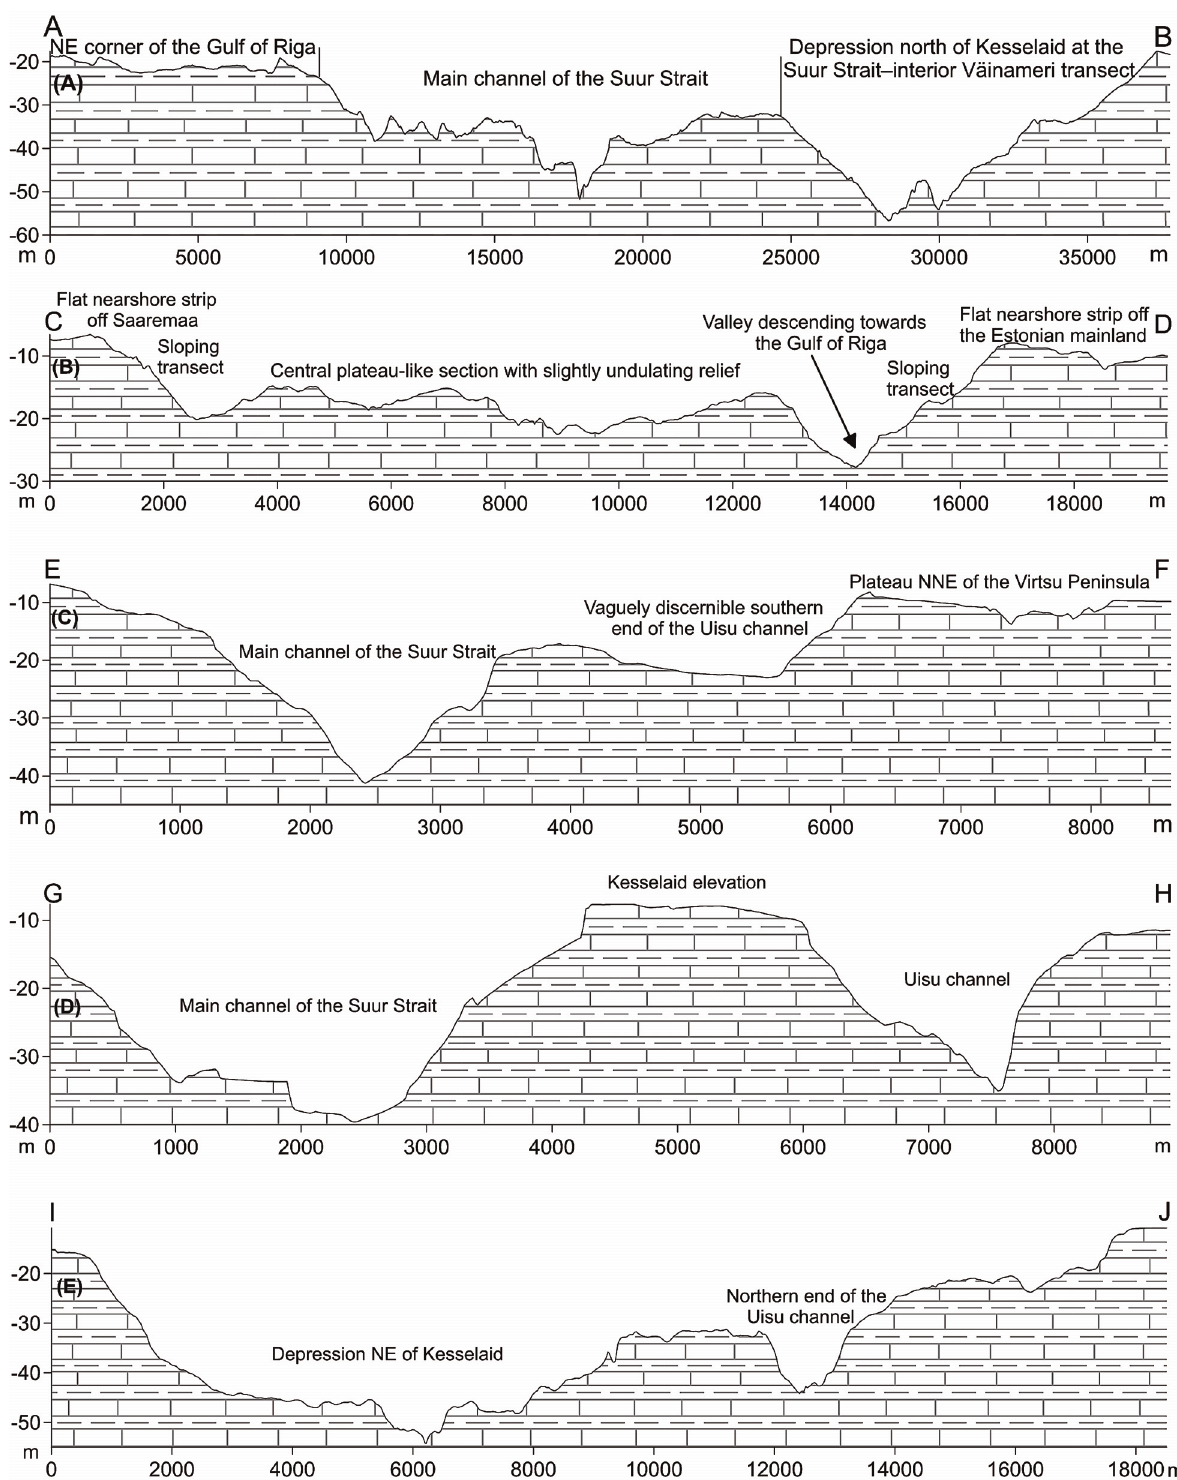
Fig. 6. Cross-sections of the bedrock relief showing the main relief features in different parts of our study area. For locations of the profiles, see Fig.